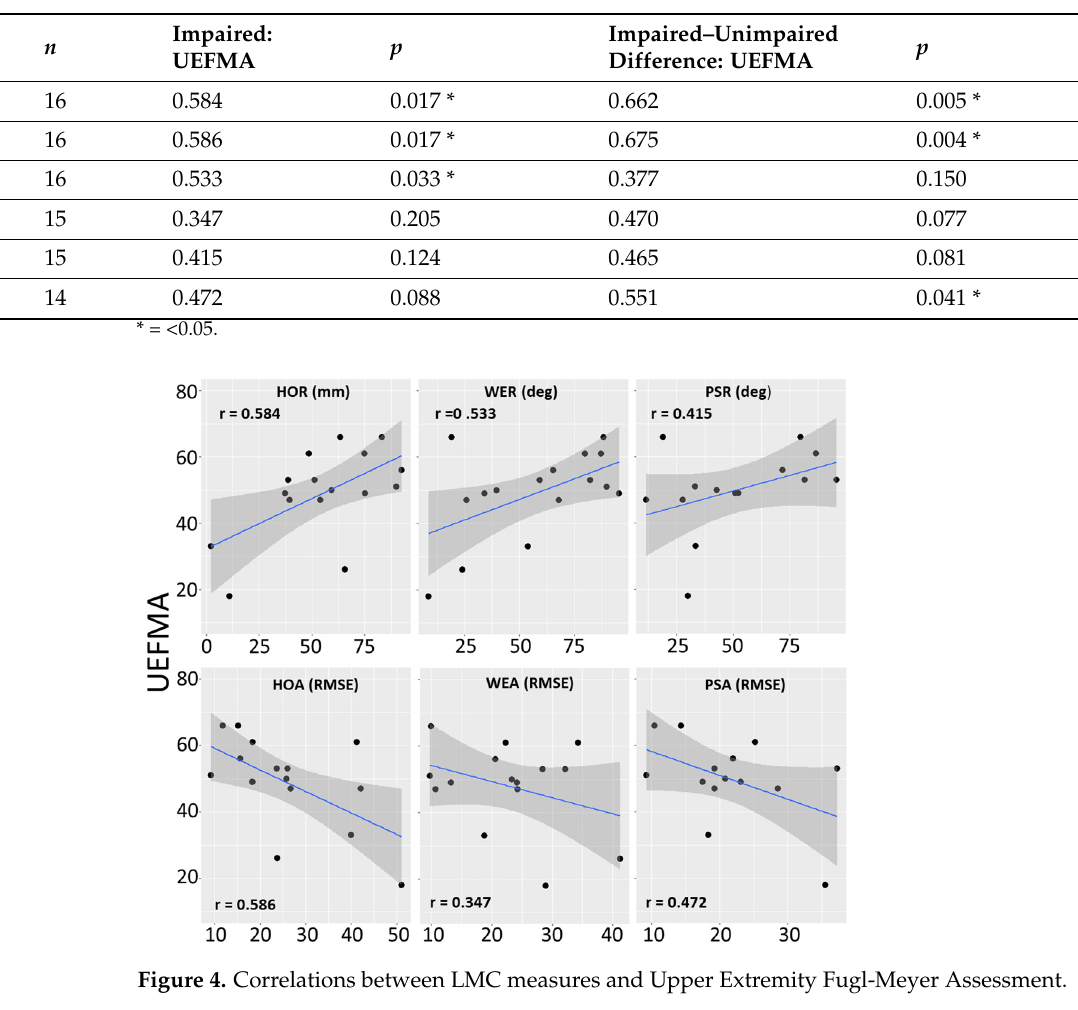
Table 5. Correlations between Kinematic Scores and Upper Extremity Fugl-Meyer Assessment Scores.